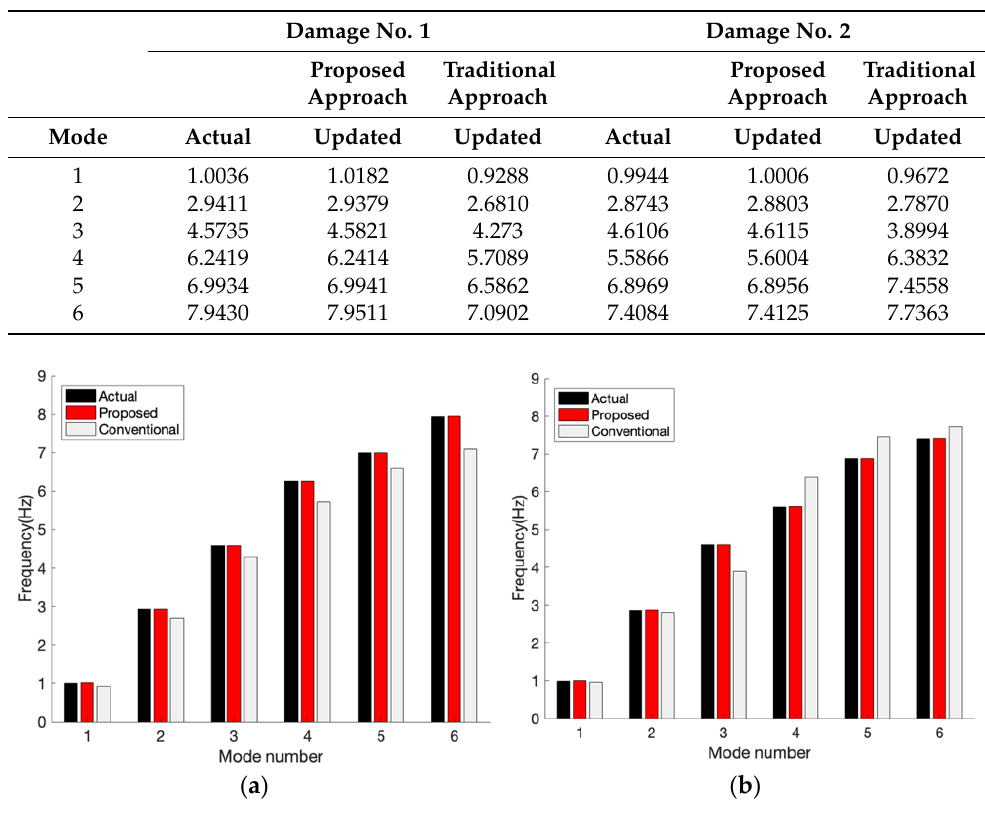
Figure 4. Updated frequencies by two approaches: ( a ) damage case No. 1; ( b ) damage case No. 2.